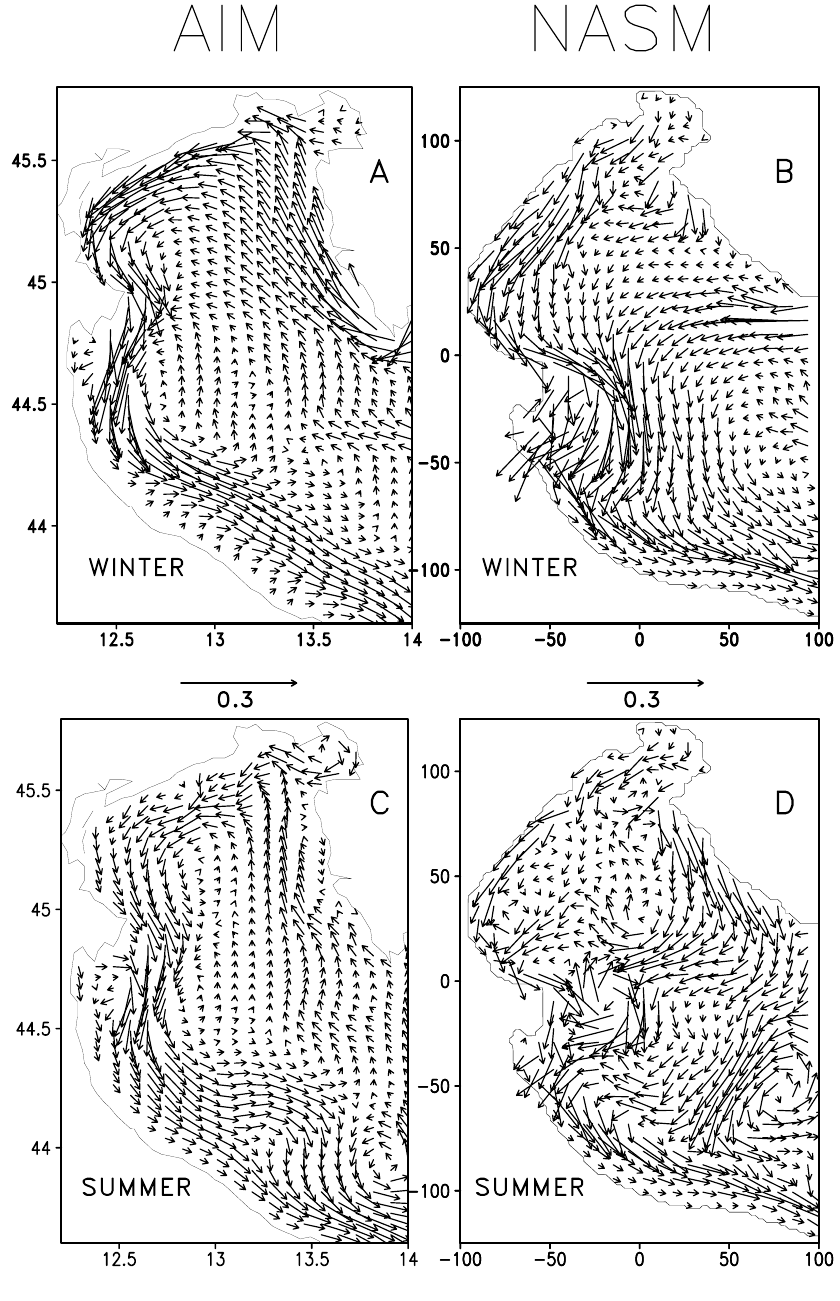
Fig. 15. Northern Adriatic Shelf Model (NASM) 2m depth seasonal (winter and summer) circulation com- pared with the corresponding AIM sim- ulation. (A) : AIM winter, (B) : NASM winter, (C) : AIM summer, (D) : NASM summer. Units are m/s. Not all grid points are plotted. Seasons definition as in Artegiani et al.